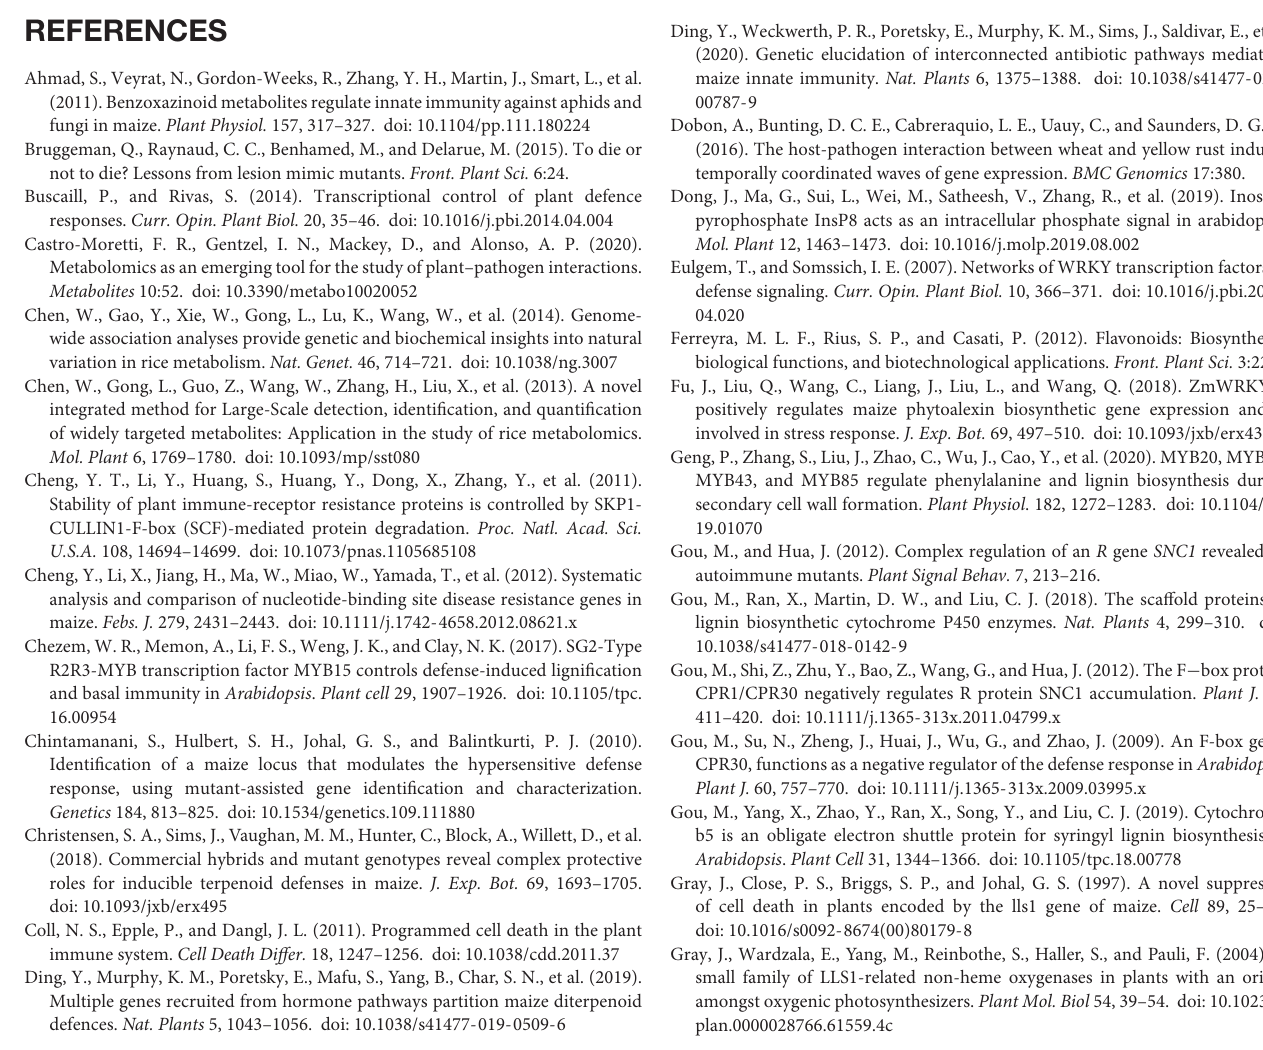
Supplementary Table 4 | Fold change of gene expression profiles detected by qRT-PCR. Supplementary Table 5 | Gene ontology term analysis of differentially expressed genes in Les4 , Les 10 , and Les17 . Supplementary Table 6 | Predicted Pathogen Receptor Genes (PRGs) in specific differentially expressed genes of Les4 , Les10 , and Les17 . Supplementary Table 7 | Predicted Pathogen Receptor Genes (PRGs) in common differentially expressed genes of Les4 , Les10 , and Les17 . Supplementary Table 8 | Transcriptomic comparison enrichment analysis of common differentially expressed genes. Supplementary Table 9 | Kyoto Encyclopedia of Genes and Genomes analysis of common differentially expressed genes. Supplementary Table 10 | Transcription factors in the common differentially expressed genes. Supplementary Table 11 | The detected metabolites in Les4 , Les10 , and Les17 compared to their respective wild type by LC-MS.